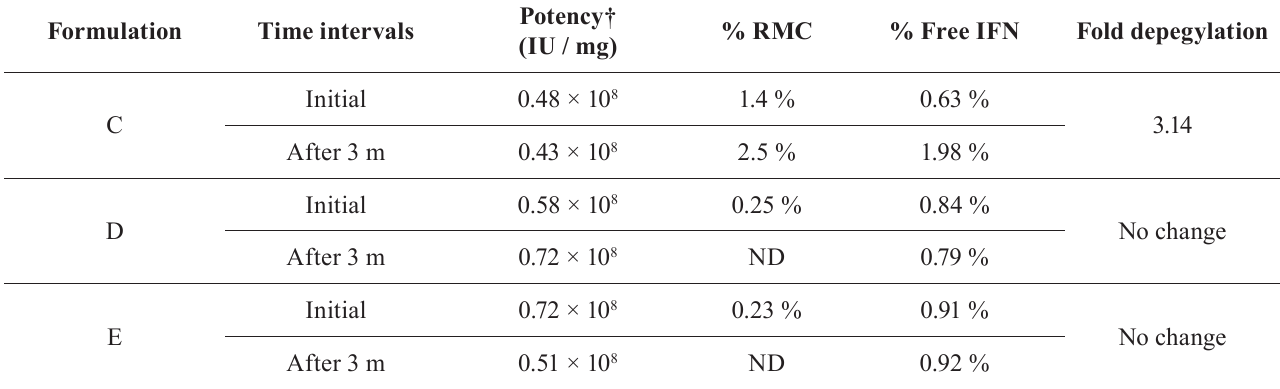
TABLE IV - Depegylation of peginterferon alfa-2b conjugate – Formulation C, D, E and F stored under Real-Time storage conditions